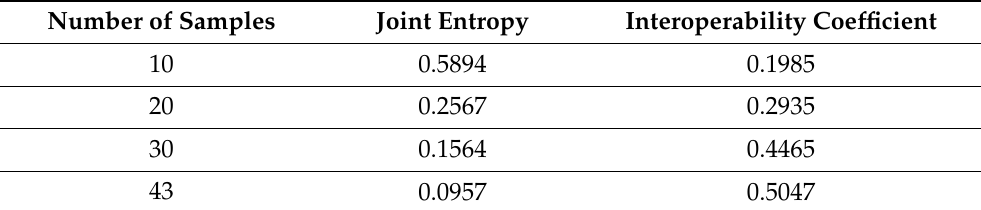
Table 2. Estimated minimum real samples needed to build the VR